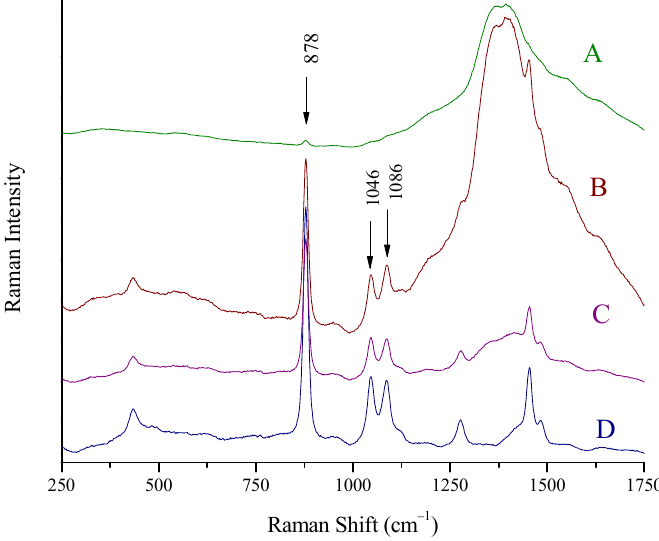
Figure 4. Raman spectra of a spirit (whiskey, 43% vol) recorded using the Raman portable system and the “through the container” method. ( A ) The laser is focused in front of the glass wall, ( B ) the laser is focused on the glass wall, ( C ) the laser is focused in the main volume of the liquid through the glass wall, and ( D ) Raman spectrum of the same spirit using the Raman cuvette. Major peaks of ethanol in the whiskey at 878, 1046, and 1086 cm − 1 are marked.